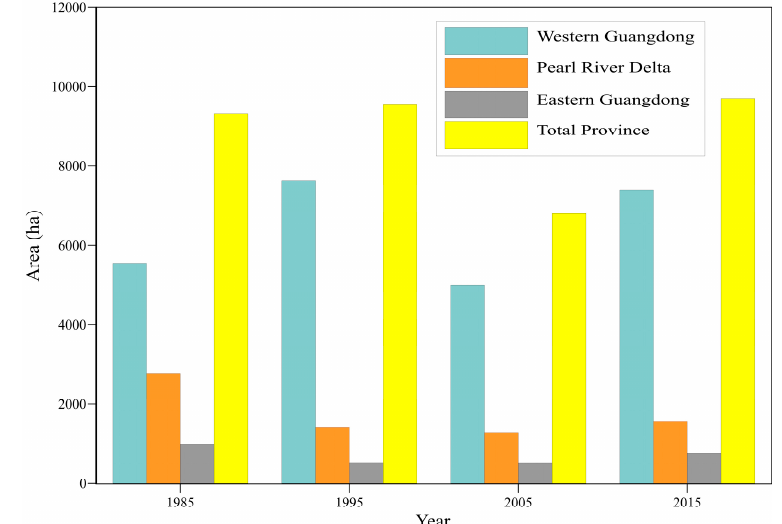
Figure 6. Total area of mangroves in coastal Guangdong during the period from 1985 to 2015.